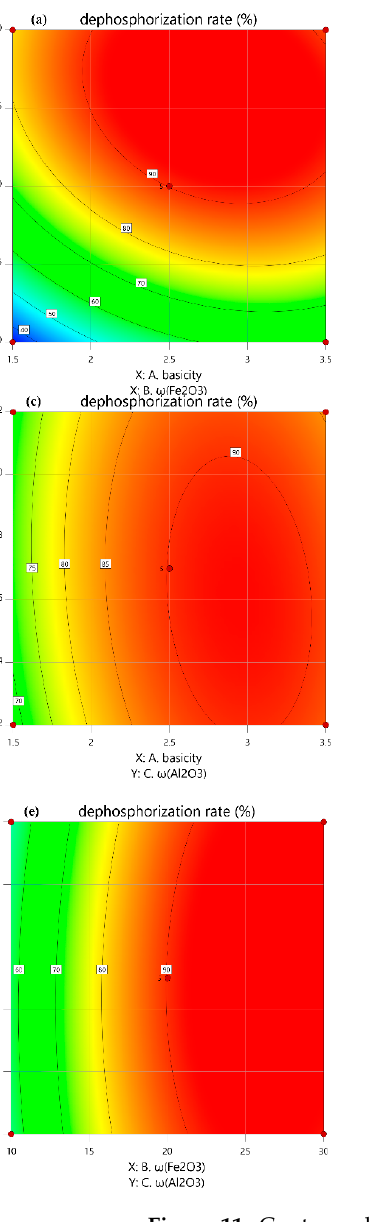
Figure 10. Comparison of actual and predicted values.